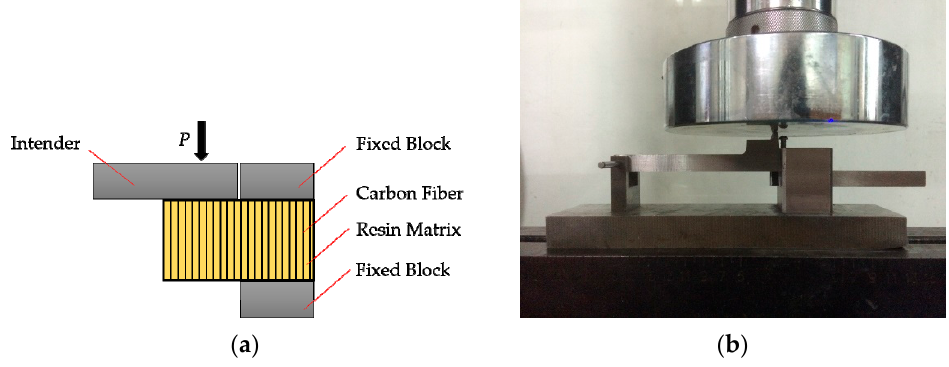
Figure 3. Set-up for in-plane shear strength (IPSS) testing. ( a ) schematic sketch, ( b ) photograph.